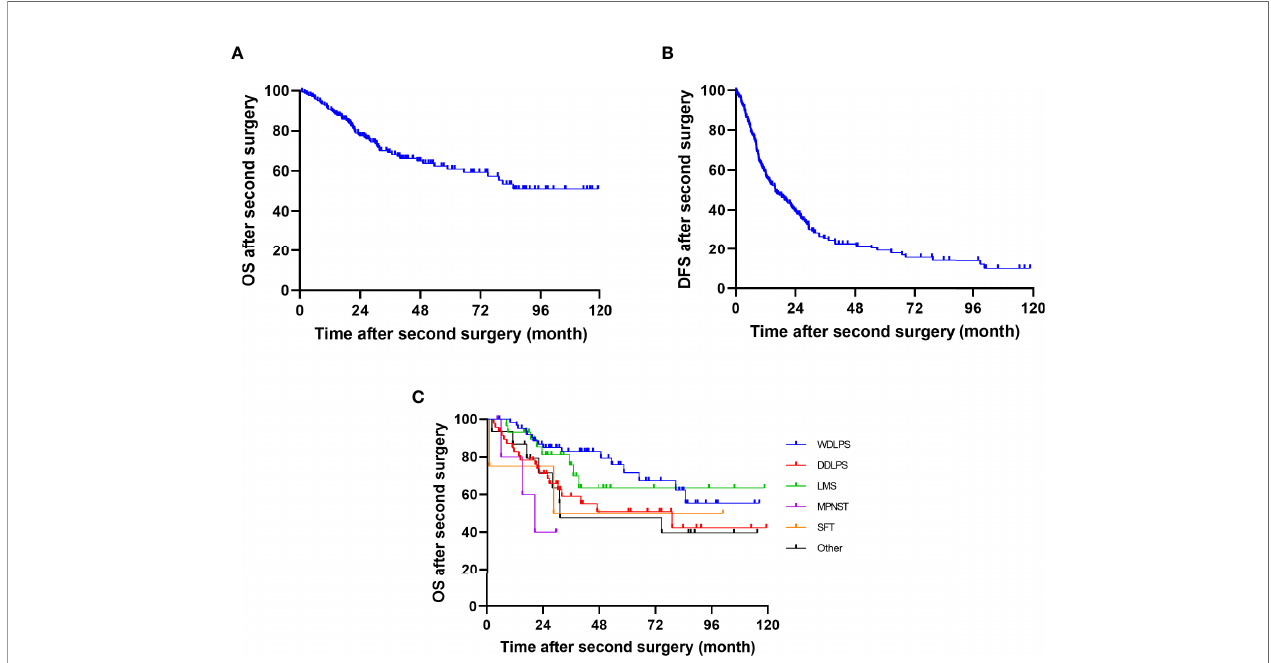
FIGURE 2 | Kaplan – Meier curves of DFS and OS after second surgery of (A) OS, (B) DFS, and (C) OS by